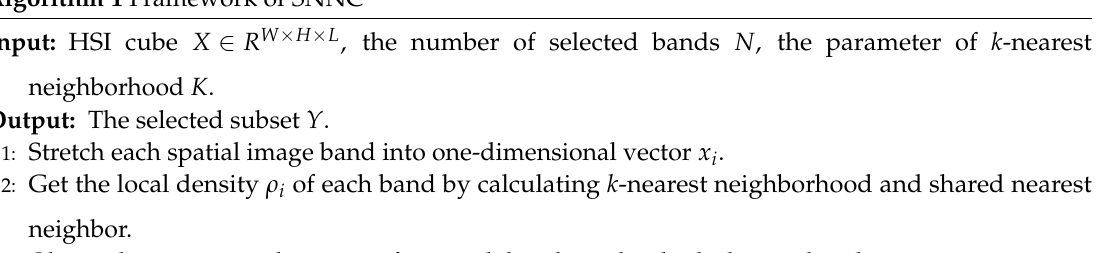
Algorithm 1 Framework of